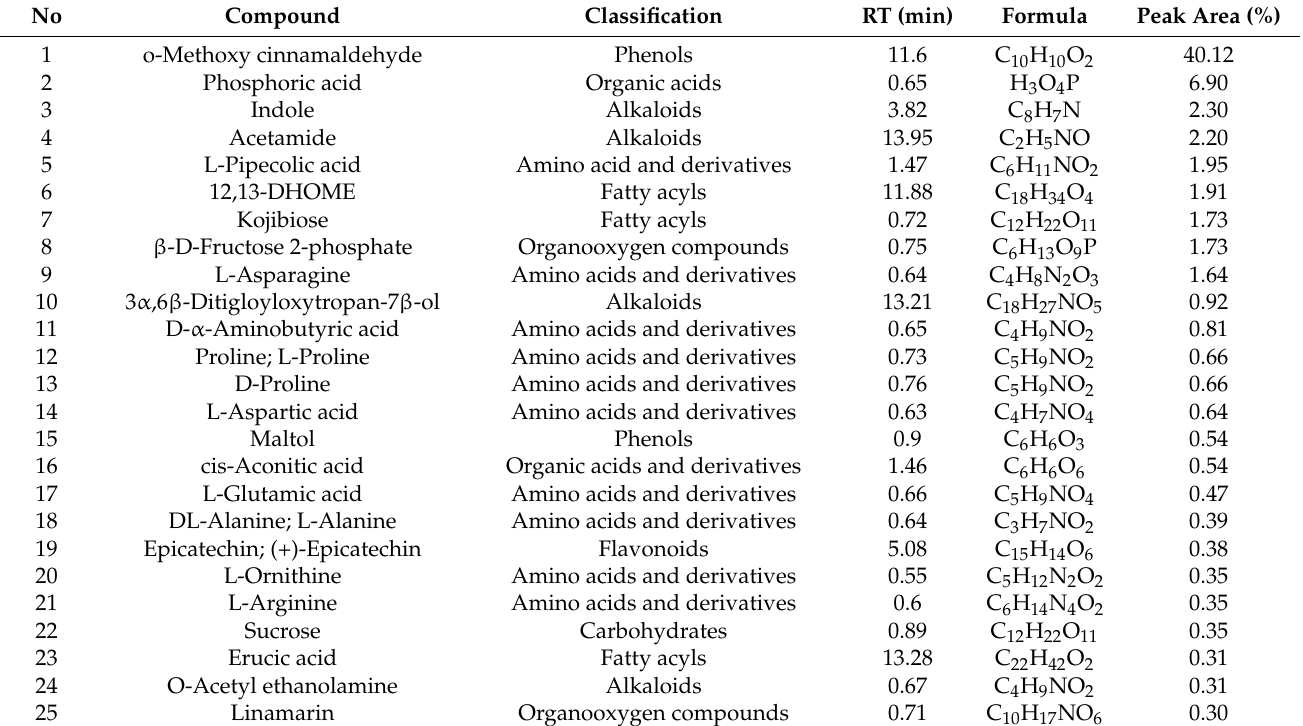
Table 3. Identification of potential antibacterial ingredients in Fraction 1 of the